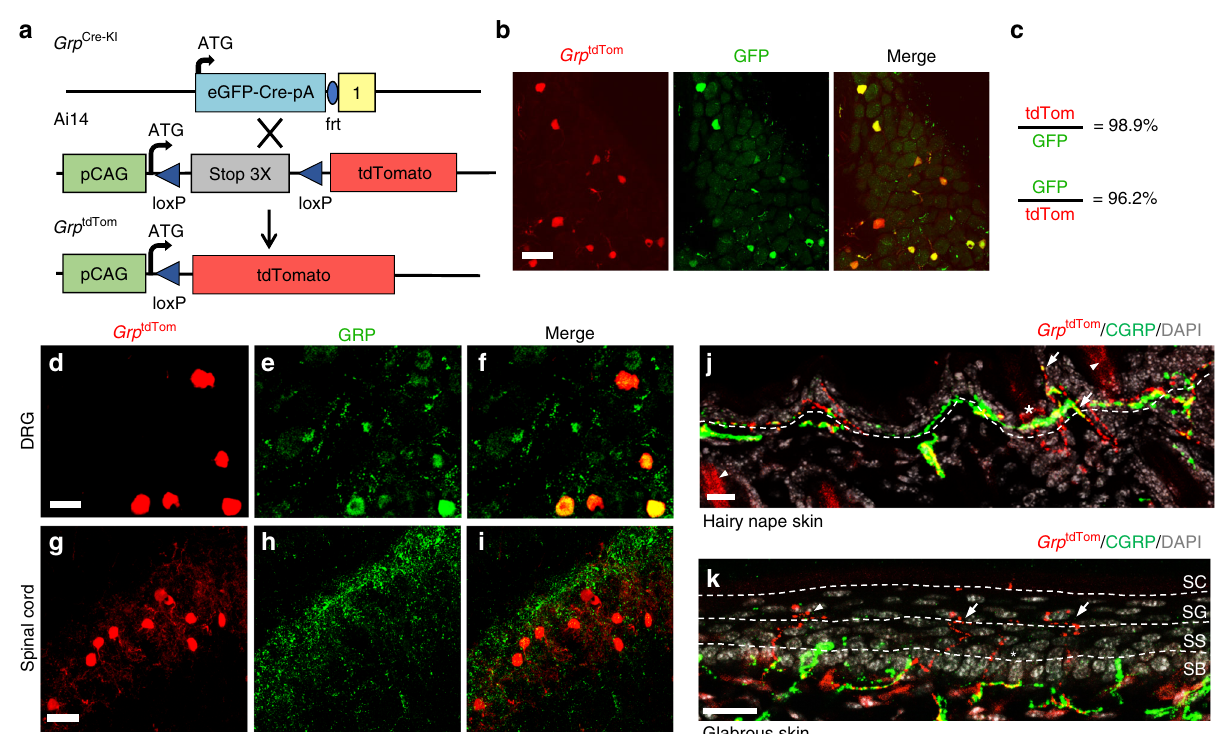
Fig. 2 Grp tdTom recapitulates Grp expression in DRG and the spinal cord. a Schematic of Grp Cre-KI mating with Ai14 reporter line to produce Grp tdTom mice. b IHC images of eGFP and tdTomato epi fl uorescence in Grp tdTom DRG. Scale bar, 50 μ m. c Percentage of eGFP + neurons co-expressing tdTomato or of tdTomato + neurons co-expressing eGFP. n = 3 mice and 10 sections. d – f IHC images of tdTomato epi fl uorescence ( d ) and GRP ( e ) in Grp tdTom DRG. Scale bar, 20 μ m. g – i IHC of tdTomato epi fl uorescence ( g ) and GRP ( h ) in Grp tdTom spinal cord. Scale bars, 50 µ m. j IHC image of tdTomato, CGRP and DAPI in Grp tdTom nape skin. Arrows indicate apparent Grp tdTom fi bers co-expressing CGRP. Arrowheads indicate auto fl uorescent hair shafts. Dashed line indicates epidermal/dermal boundary. k IHC images of tdTomato, CGRP, and DAPI in glabrous paw skin with stratum basilis (SB), stratum spinosum (SS), stratum granulosum (SG), and stratum corneum (SC) epidermal layers marked by dashed lines. Arrows indicate Grp tdTom fi bers with ‘ S ’ or ‘ Z ’ pattern nerve endings. Arrowhead indicates Grp tdTom fi bers with apparent bush endings. Scale bars, 20 μ